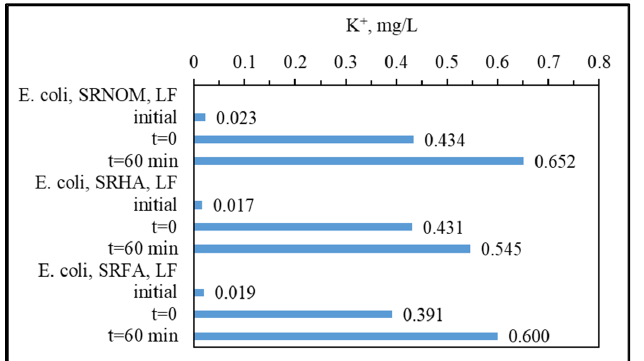
Figure 13. Change in K + content in the presence of NOM analogous prior to and following the SPCI of E.coli using LF.